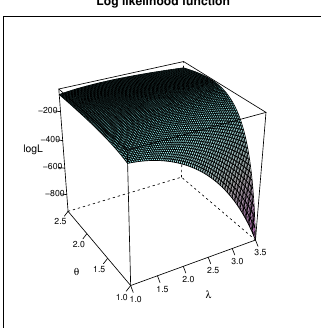
Figure 4 – Log likelihood plot for the real data set